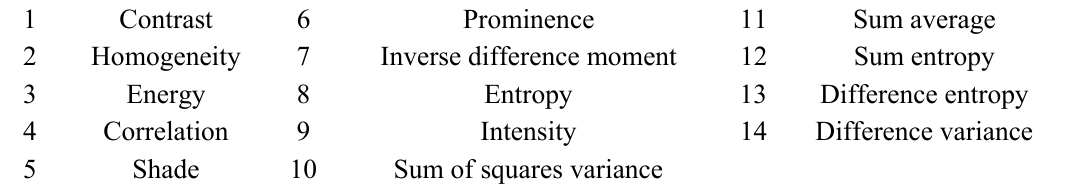
Table 1. Fourteen textural features were extracted from GLCM